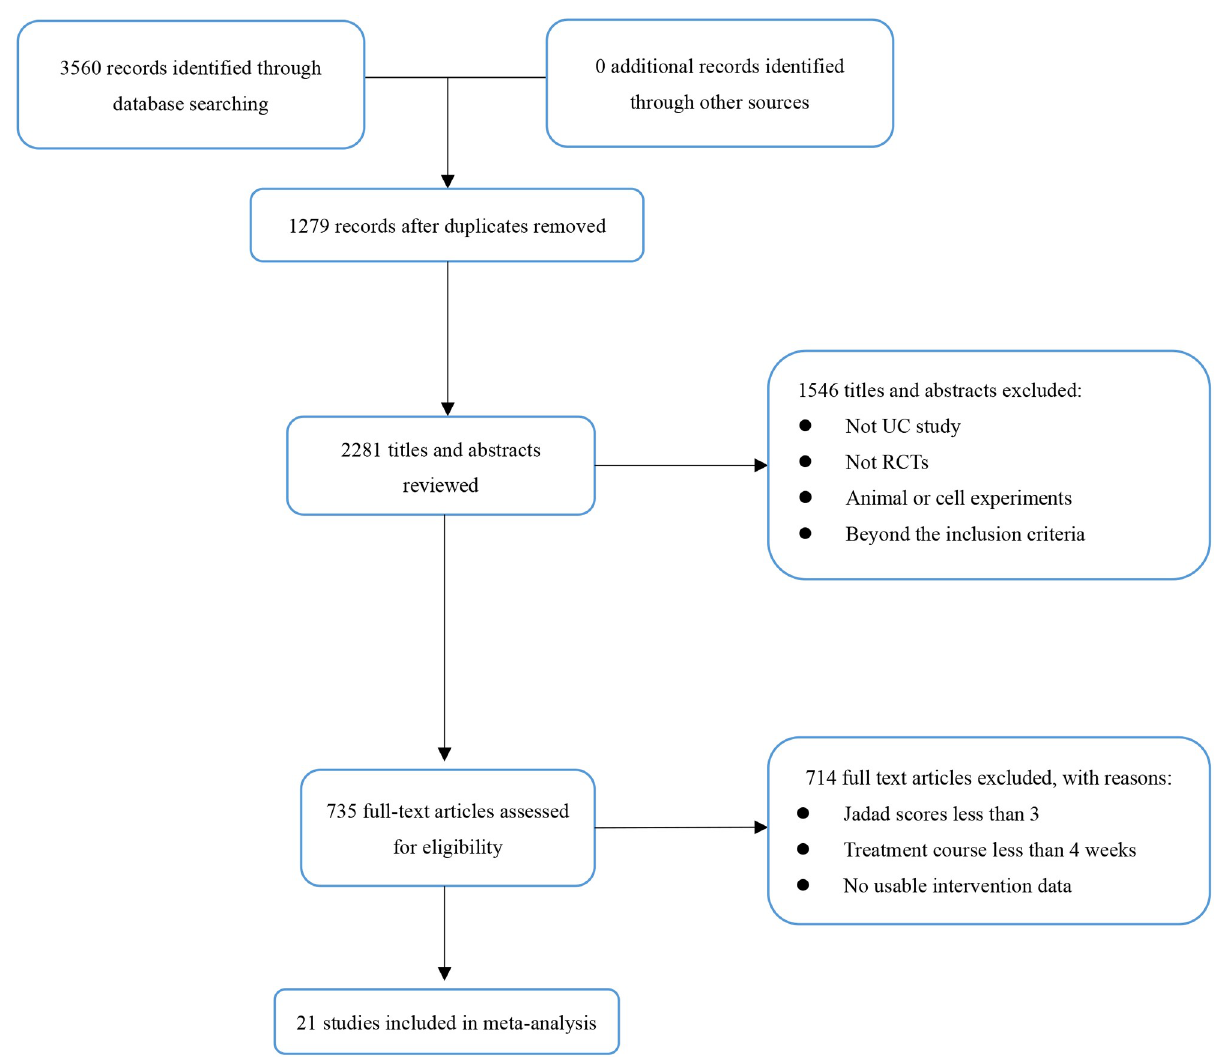
Fig 1. Flowchart of the process for literature retrieval. UC: Ulcerative colitis; RCTs: Randomized controlled trials.